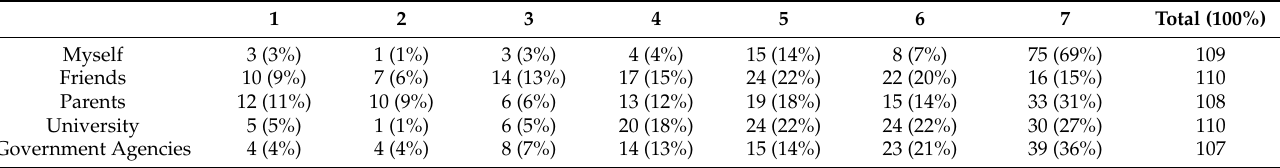
Table 3. Responsibility for students’